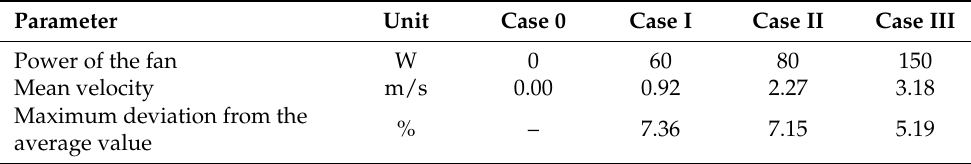
Table 3. The summarised results that were obtained from profile measurements.